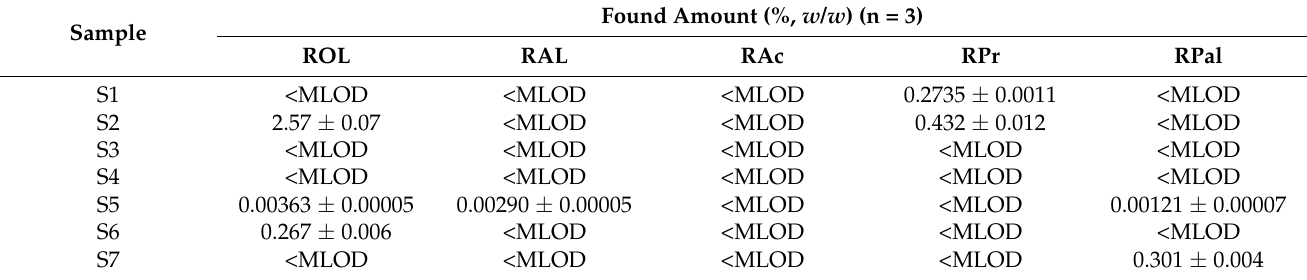
Table 5. Retinoids content in seven commercial cosmetics applying the proposed method.